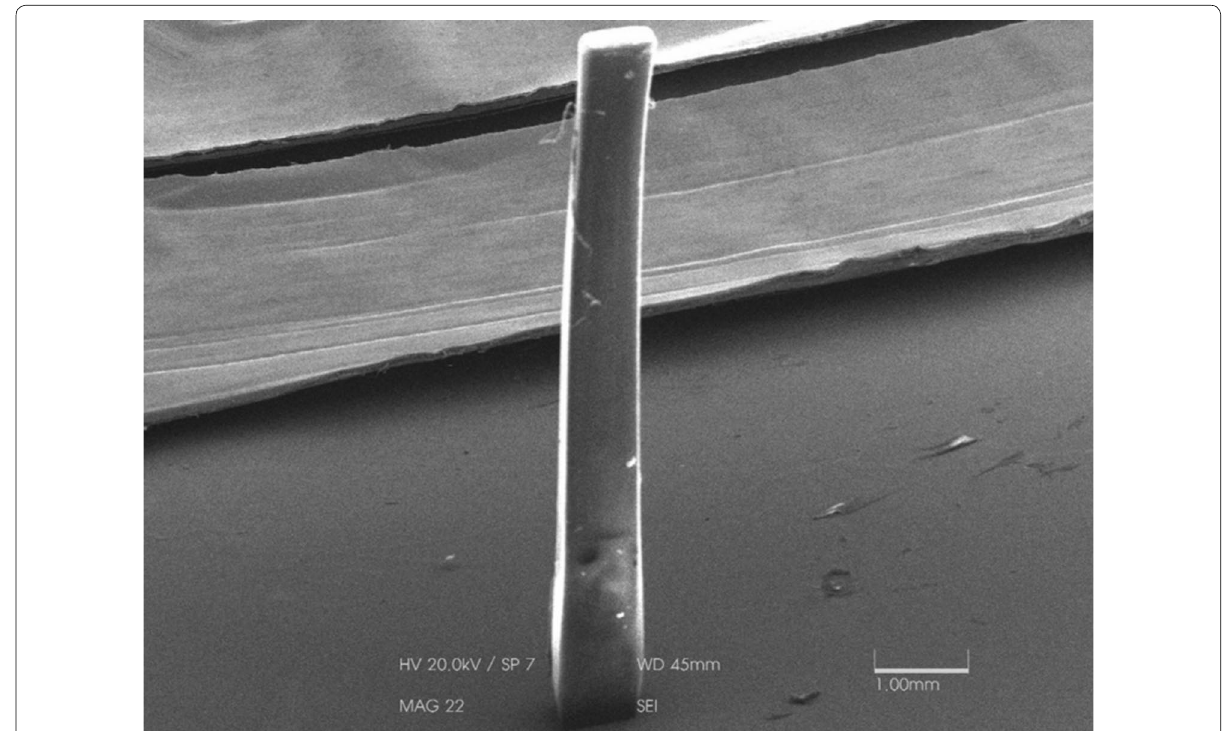
Fig. 7 Seven-millimeter-tall